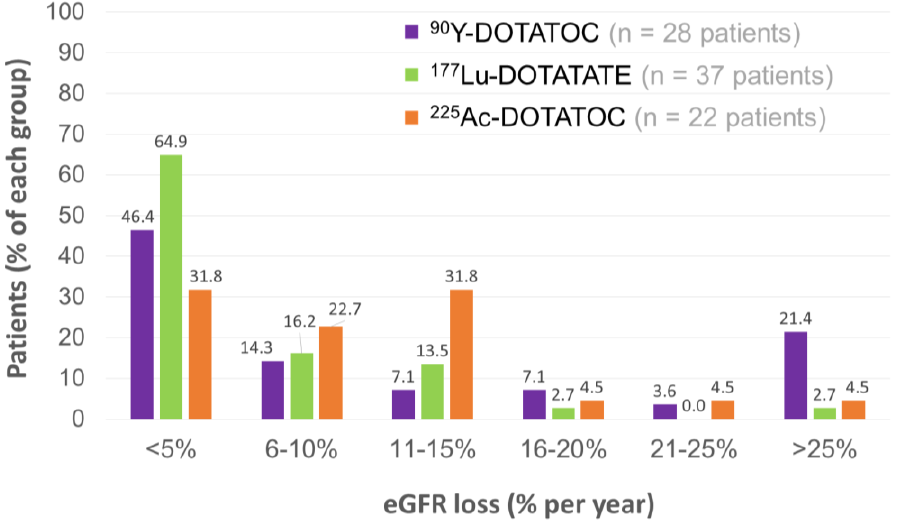
Figure 9. Distributions of patients with respect to the extent of annual GFR loss for β -PRRT and TAT [207–210].